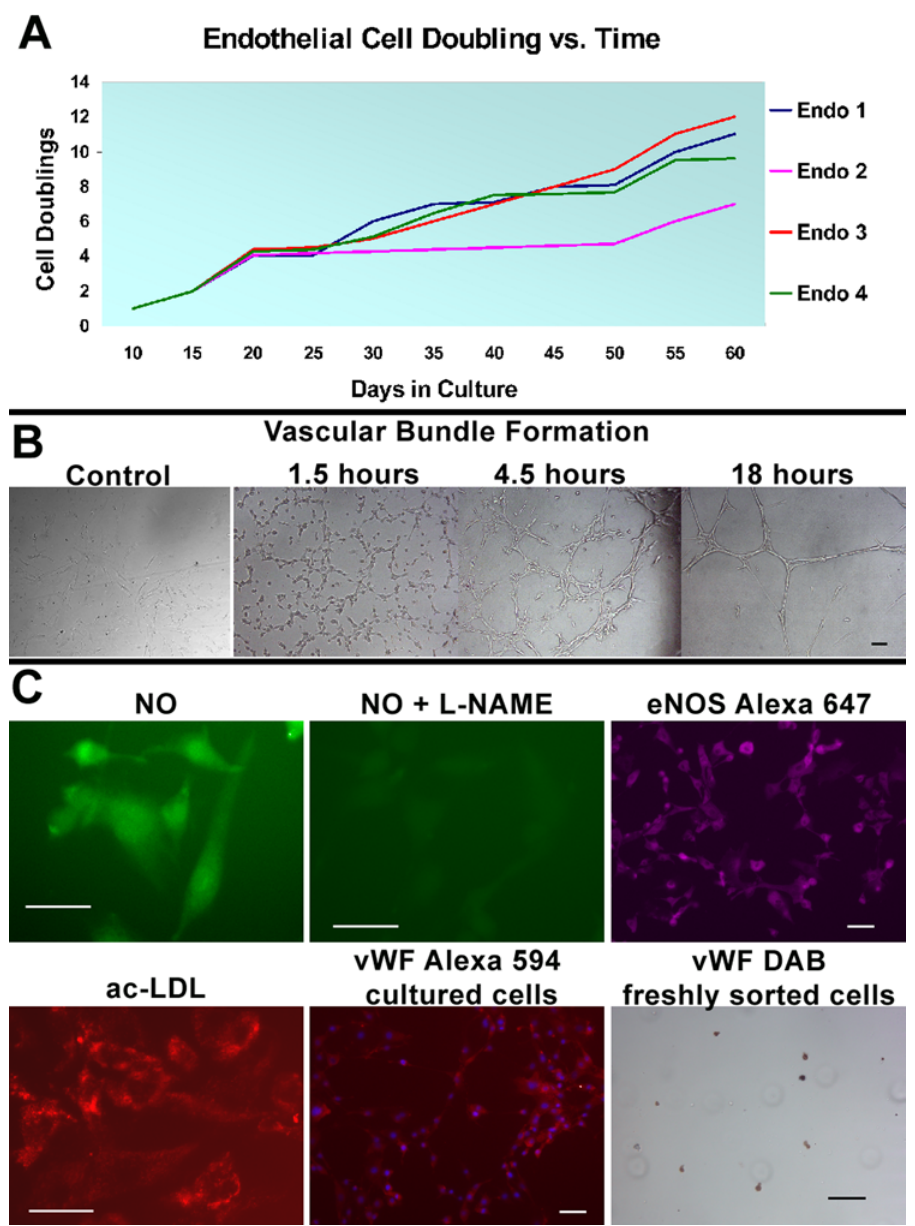
Figure 4. FACS sorted EC can be culture-expanded and preserve endothelial functions in culture. A, Growth rate comparison for muscle EC lines derived individually from four 25 MO C57BL6 males, cultured in DMEM with 10% FCS and 10 ng/ml VEGF for 60 days. B, Vascular bundle formation occurs rapidly within 18 hrs of cells being seeded on pure matrigel vs. controls without matrigel. Photographs were taken at 1.5 hour intervals and after 4.5 hours left overnight in culture. C, Top panel shows endothelial specific NO production. Left, muscle EC can produce NO as detected by green fluorescence emission of DAF-2T. Middle, NO production was inhibited by L-NAME. Right, muscle EC stained with rabbit anti-eNOS followed by anti-rabbit Alexa 647 show strong staining in endothelial caveolae. Bottom panel shows other functional assays as well as maintenance of vWF expression. Left, cultured muscle EC uptake ac-LDL- rhodamine (red fluorescence). Middle, skeletal muscle derived EC in culture retain vWF expression for more than 80 days as portrayed by anti-vWF with Alexa 594. Right, 99.9% of freshly FACS-sorted muscle EC stained positive for vWF immunoperoxidase with DAB (brown). Scale bar=50 m m.